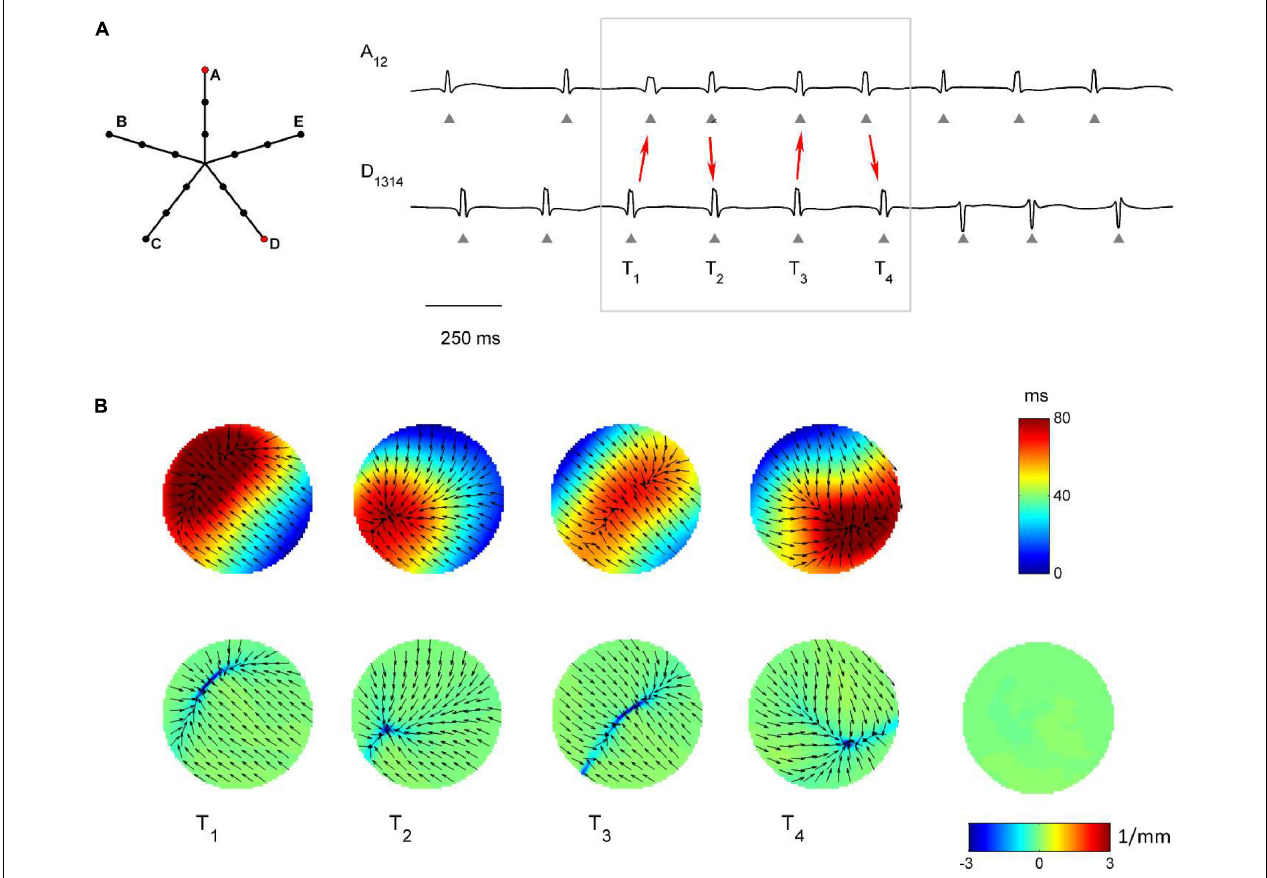
FIGURE 7 | Application of divergence analysis to simulated atrial fibrillation in the region dominated by multiple wavelets propagation. (A) Schematic representation of the multipolar mapping system, indicating the central position of the bipoles, and representative synthetic AF electrograms corresponding to the red bipoles of the catheter. Arrows in the electrograms indicate changes in the activation sequence. (B) Beat-to-beat reconstructed activation (top) and divergence maps (bottom), corresponding to the evidenced beats. The average divergence map over the analyzed epoch is displayed in the bottom right panel. The absence of a stable propagation pattern is evidenced by the almost-zero values of the average divergence map